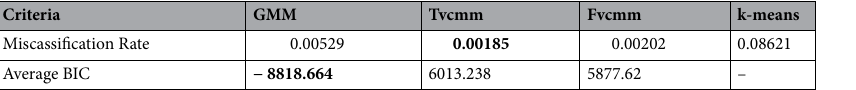
Table 3. The summary of the performance of the Tvcmm and Fvcmm, GMM, and k-means methods fitted to the simulated data with 500 observations. Tvcmm, Fvcmm, GMM, and k-means refer to the truncated vine copula mixture model, full vine copula mixture model, Gaussian mixture model and the k-means method, respectively.